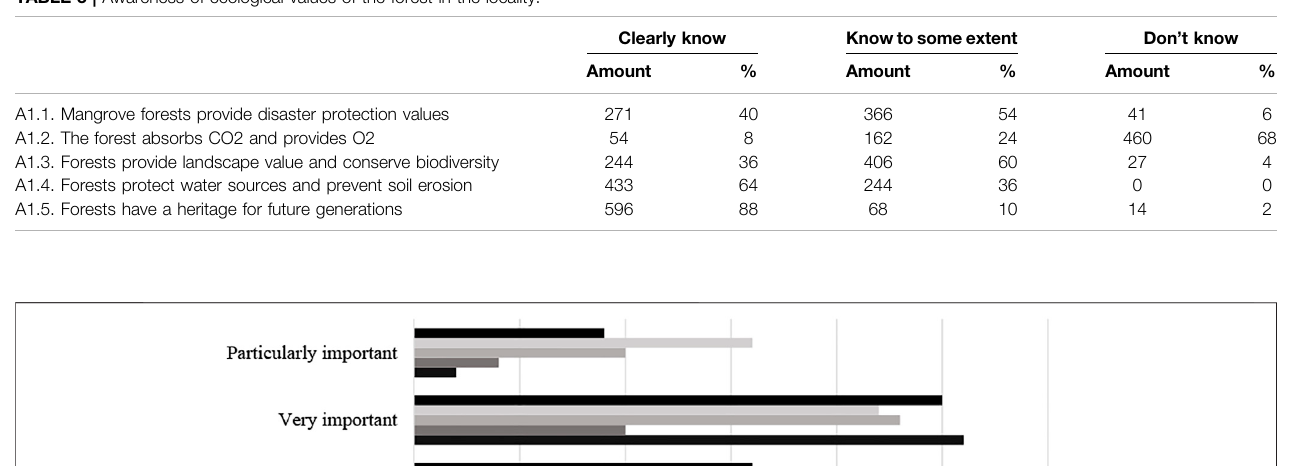
TABLE 3 | Awareness of ecological values of the forest in the locality.